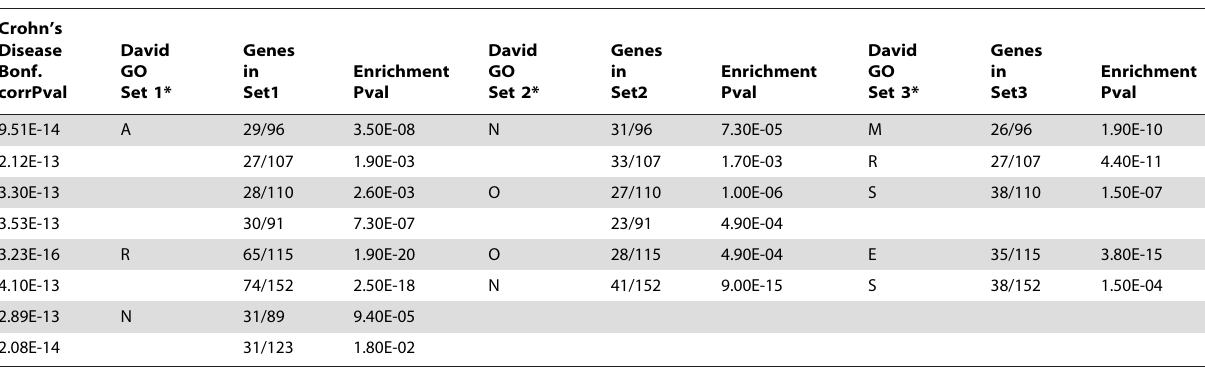
Table 2. NIMMI prioritized sub-networks for Crohn’s Disease.